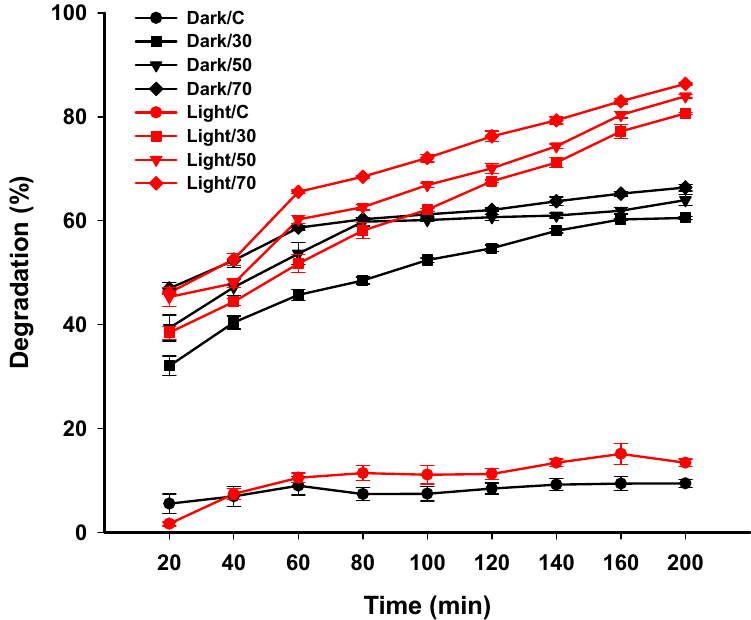
Figure 7. Photocatalytic activity of green synthesized Ag-NPs for degradation of methylene blue (MB) in dark and light irradiation. Data are statistically different at p ≤ 0.05 ( n = 3); error bars are means ± SD. The standard deviation is less than the size of the symbols if no error bars are seen.